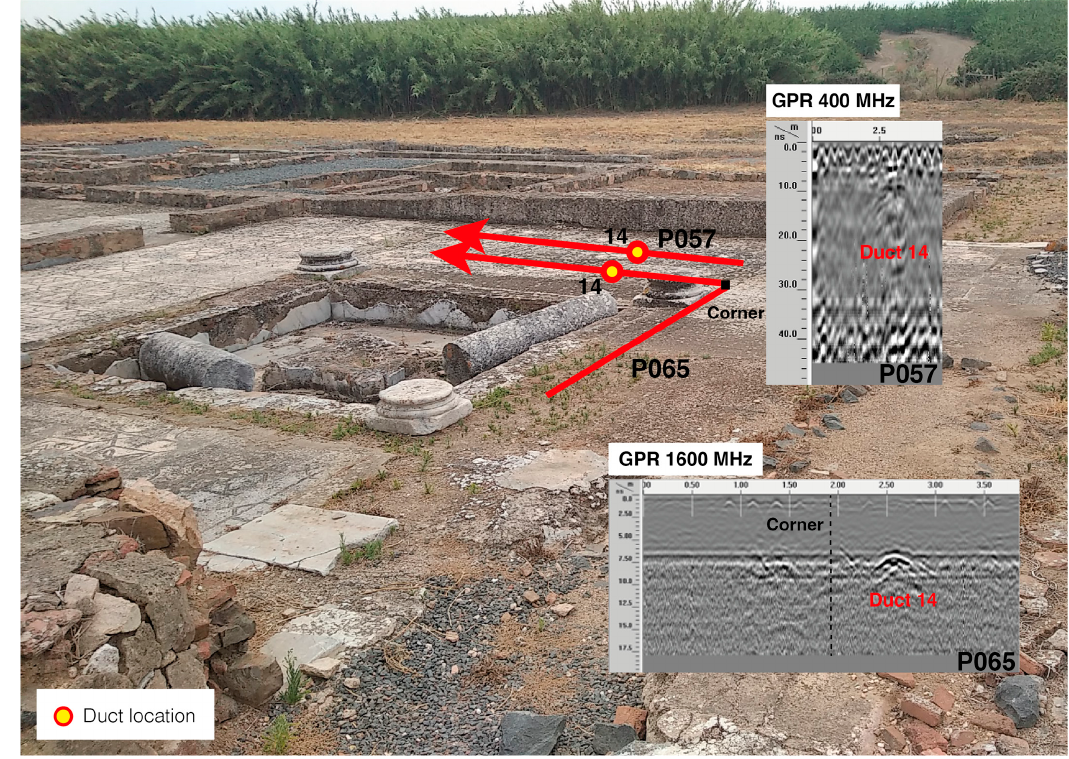
Figure 8. Representation of B-scans P057 and P065 and their location in the field.